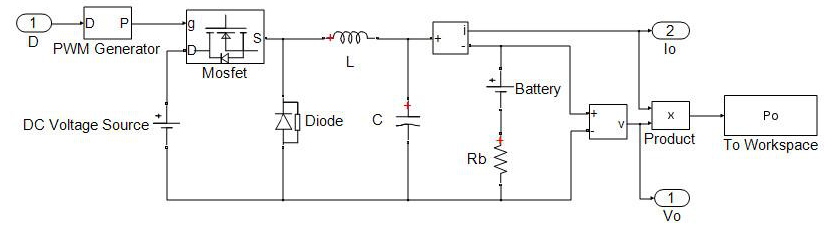
Figure 1. Electrical model of the dc-dc converter designed in MATLAB/Simulink.